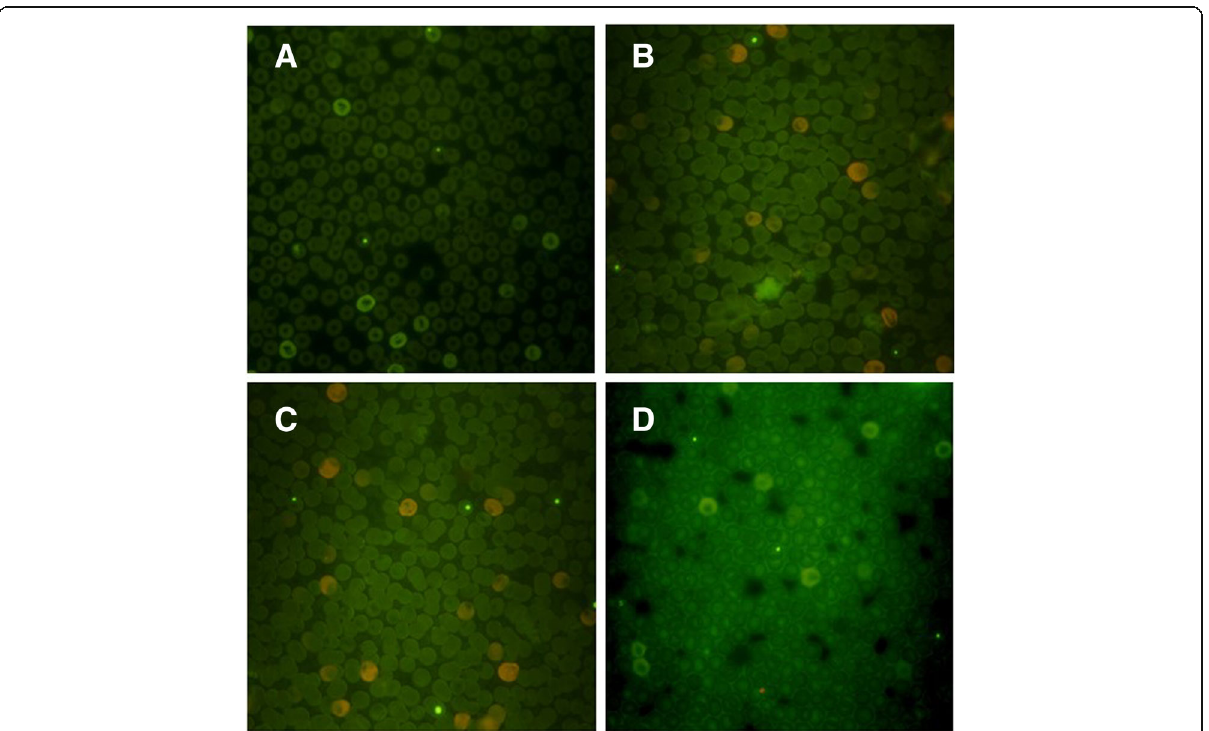
Fig. 1 Micronucleus test of Control Group with and without Moringa oleifera . a Control Group, water. b M. oleifera Group, 100 mg. c M. oleifera Group, 250 mg. d M. oleifera Group, 500 mg. No significant changes was observed in all smears between control Group and M. oleifera treatment